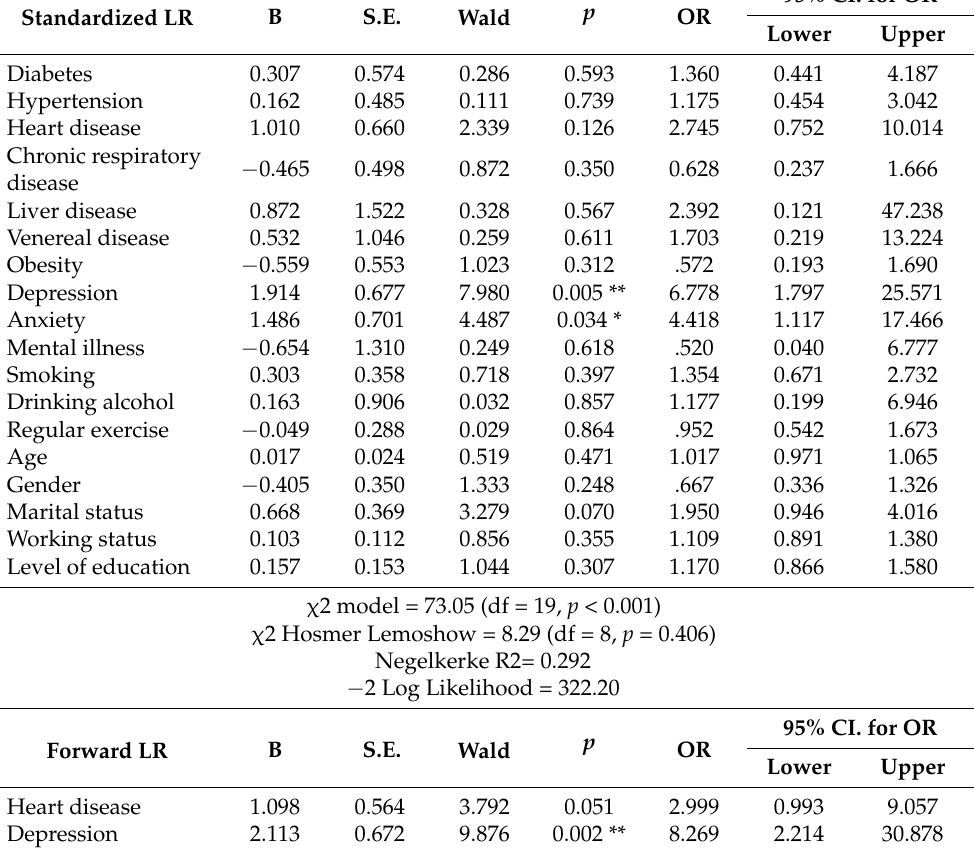
Table 4. Adjusted binary logistic